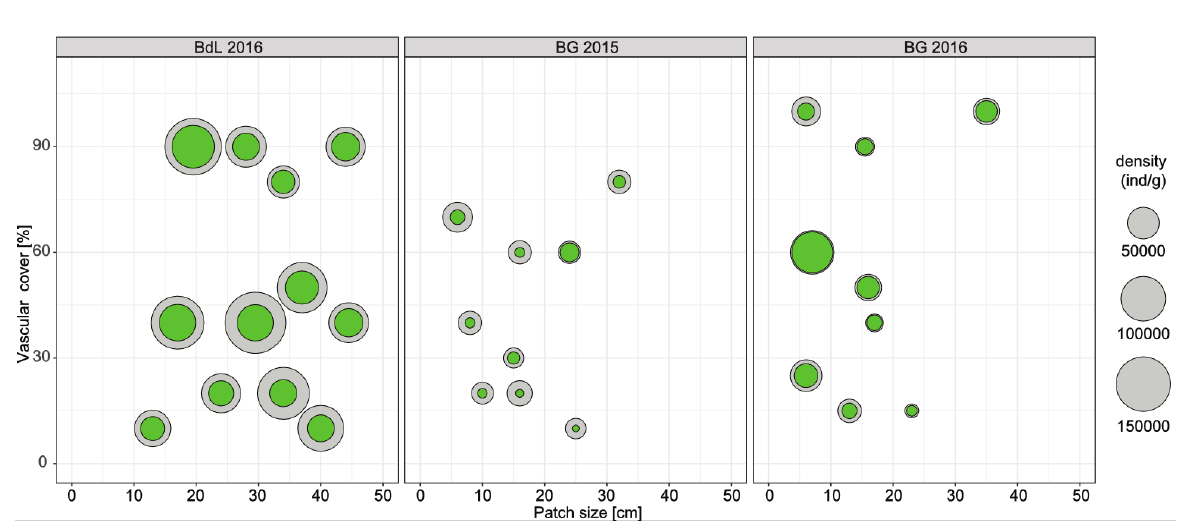
Figure 2. Biplots of overall density of testate amoebae assemblages in the Neuchâtel Botanic Garden experimental peatland (BG 2015, BG 2016) and the Bois-des-Lattes reference peatland (BdL) in relation to Sphagnum patch diameter (x axis) and percentage vascular plant cover (y axis). The area of each circle is proportional to the testate amoeba density: grey circle = total density of dead + living assemblages; superposed (green) circle = density of living assemblages. The differences in mean patch size and mean vascular plant cover between the two BG sampling dates were not significant (based on Student’s